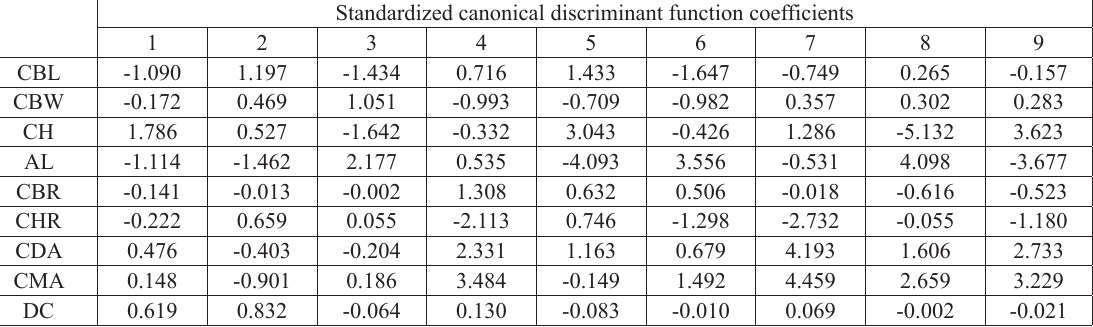
Table 3. Factors of the nine canonical vectors used in the DFA. The first and second vectors are also used in the XY graph that delineates the morphospace of the teeth. Abbreviations: AL, apical length; CBL, crown base length; CBR, crown base ratio; CBW, crown base width; CDA, crown distal angle; CH, crown height; CHR, crown height ratio; CMA, crown mesial angle; DC, distal denticles at mid-crown. Standardized canonical discriminant function coefficients